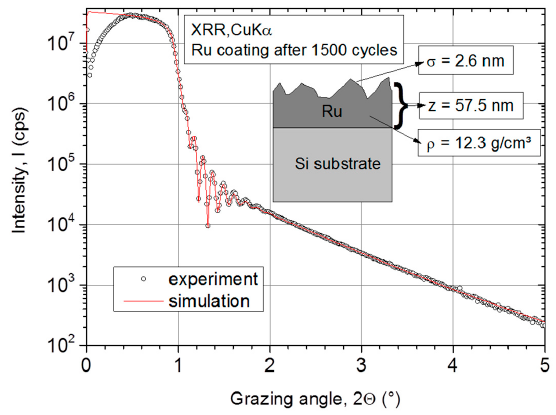
Figure 1. X-ray reflectometry (XRR) measurement on atomic layer deposition (ALD) Ru layer and corresponding simulation with a simple two-layer model (substrate + Ru thin